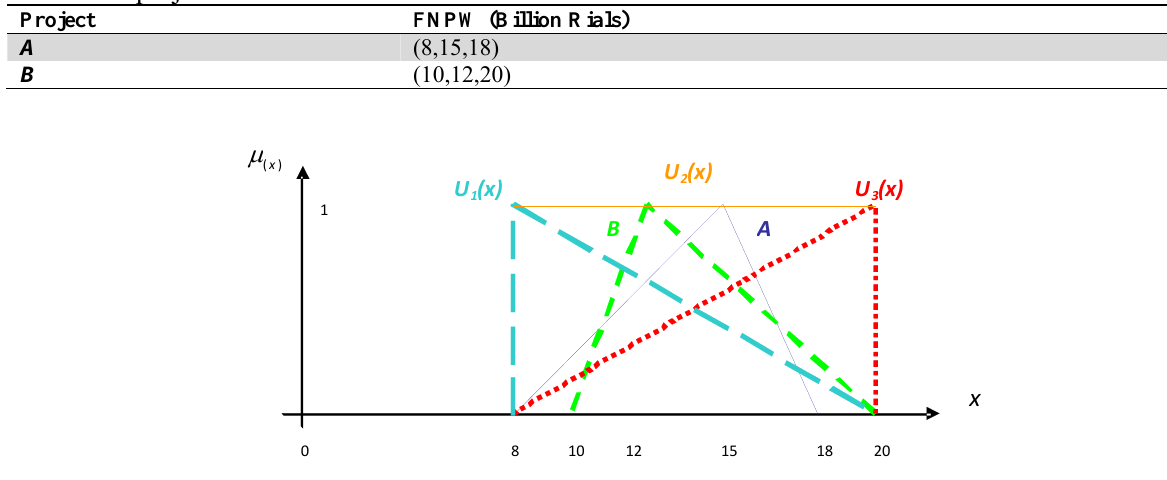
Fig. 8. Comparison of FNPW of projects A and B based on descending, constant and ascending linear utility